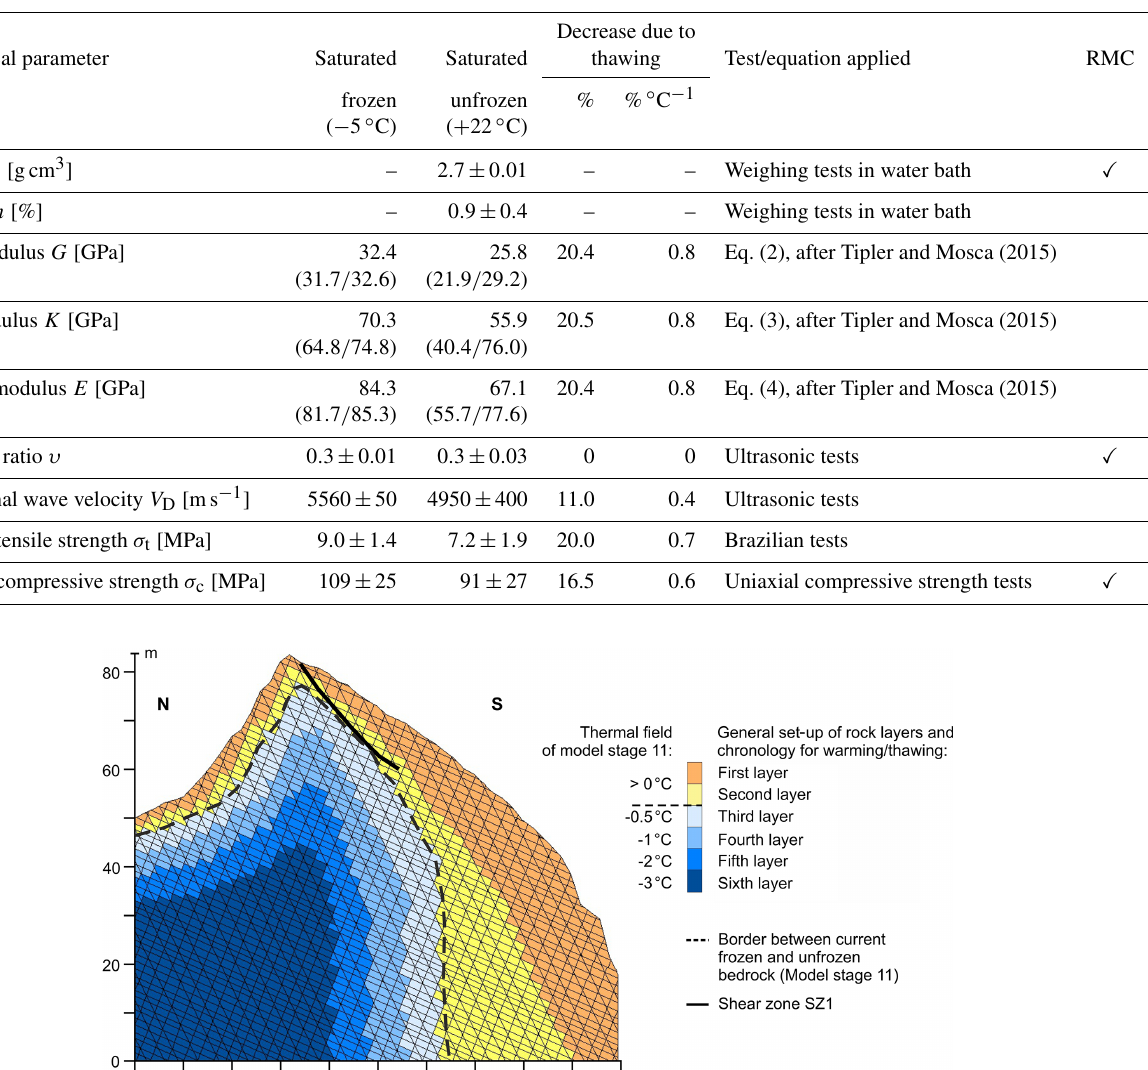
Table 3. Laboratory-tested strength reduction of intact dolomised Wetterstein limestone due to thawing. Standard deviations (indicated with ± ) are given for measured parameters, and they were used for the determination of minimum and maximum values (given in parentheses) of the calculated parameters. RMC refers to parameters that are used for rock mass characterisation.